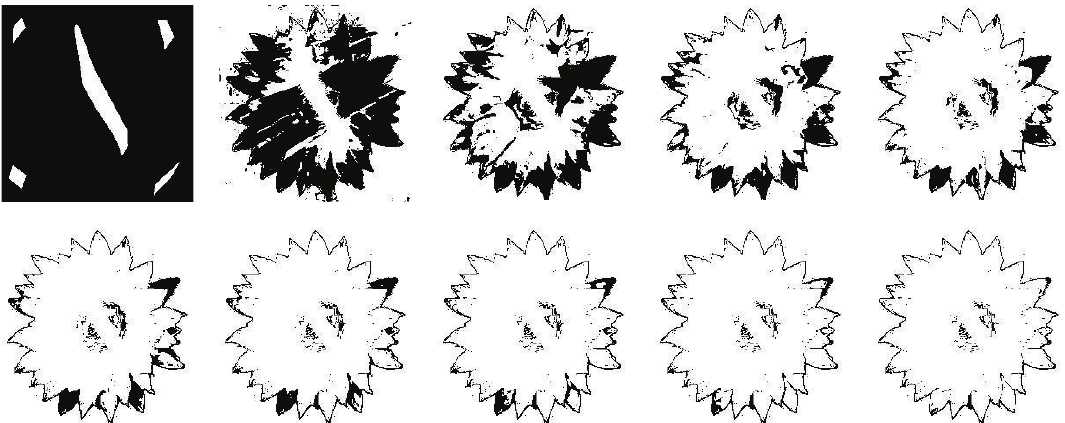
Figure 5: Unknown area for the flower segmentation shrinks in the first ten iterations. Dark area represents unknown part. The iterations converge very